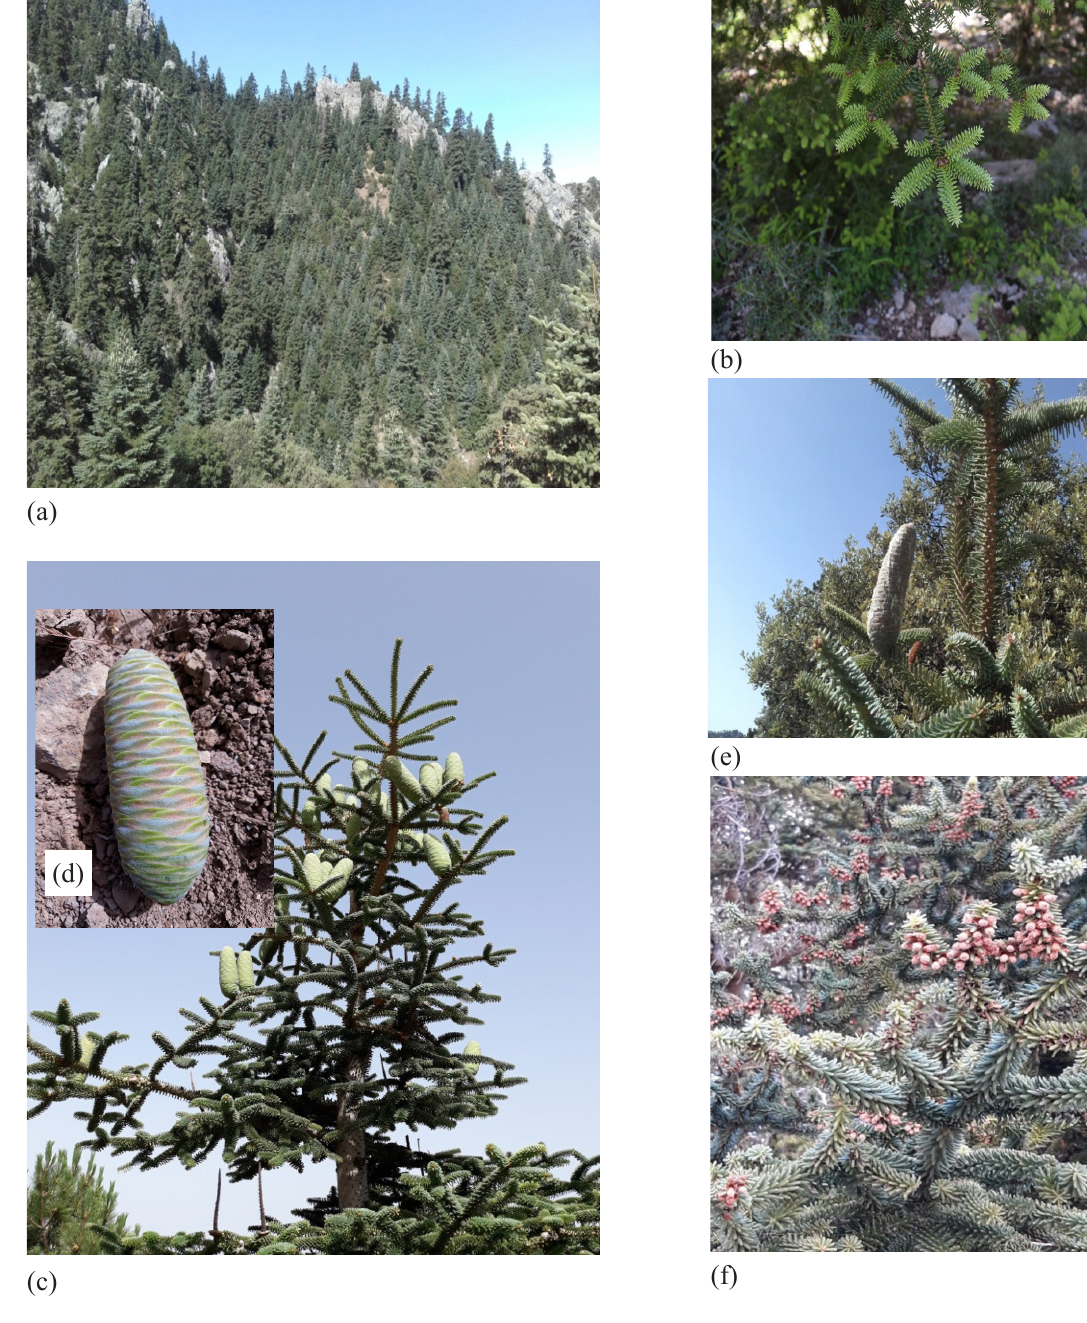
Figure 2. Illustrations of Moroccan fir Abies marocana : a, forest stand in Talassemtane National Park (07/07/2017); b, needles showing the shoot of the year in light green (Talassemtane fir forest, 25/05/2017); c, female cones which appear erect on the upper branches of the tree; d, isolated immature cone of the same individual (Tazaout fir forest) (07/10/2019); e, mature female cone covered with resin in Mont Tissouka forest (07/07/2017); f, male cones of dispersing pollen (Talassemtane fir forest, 10/07/2019). All photos by M.